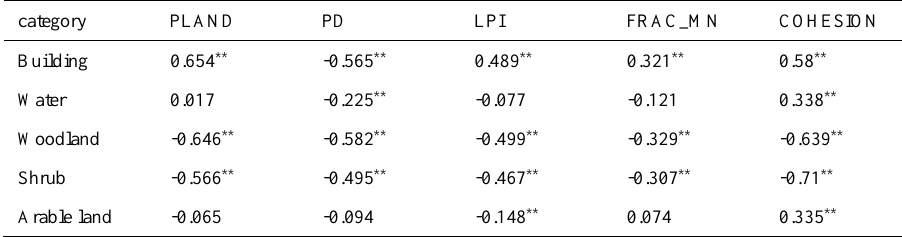
Table 2 Correlation analysis results of landscape indices and AOD